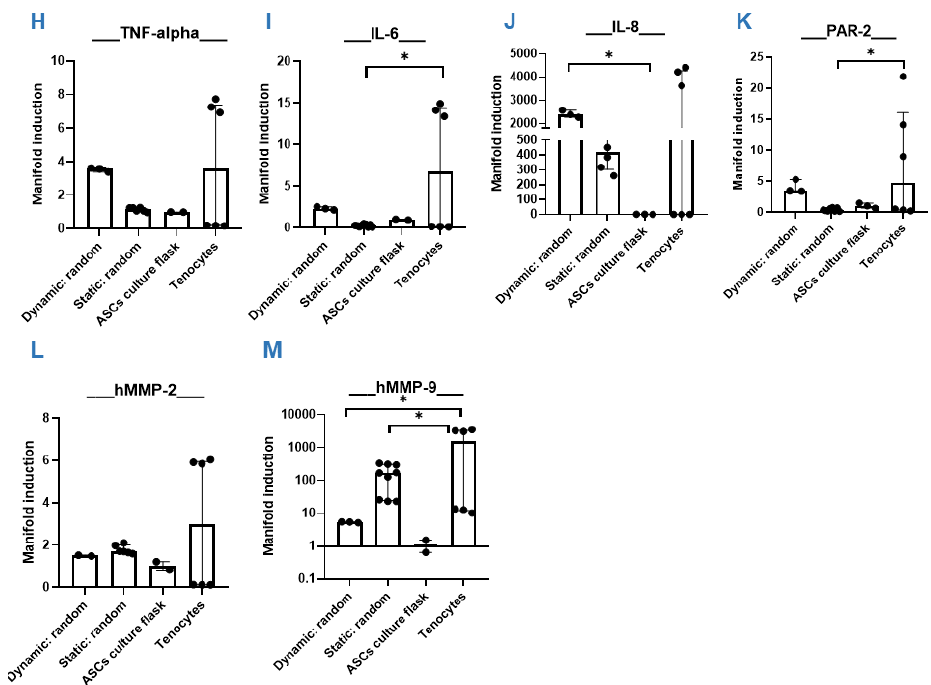
Figure 5. Dynamic versus static. Quantitative RT-PCR results of hASC on PVDFhfp/PDMS random fiber mesh under static and dynamic conditions. Gene expression (=manifold induction) of ASCs under dynamic conditions, static conditions or in culture flask (reference set to 1) or of human tenocytes as control was compared ( A – M ). Statistical analysis was performed with one-way ANOVA and data are shown as median and interquartile range, with * ( p < 0.05), ** ( p < 0.01) and *** ( p < 0.001).